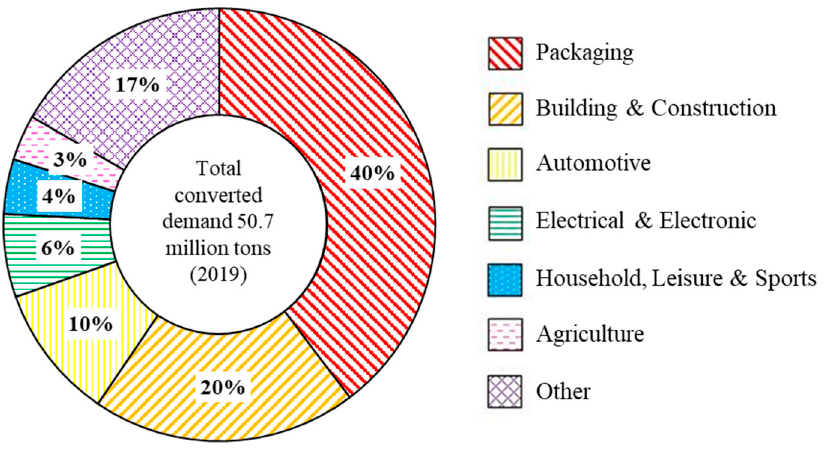
Figure 1. European industry demand for all types of plastics in 2019 [3].